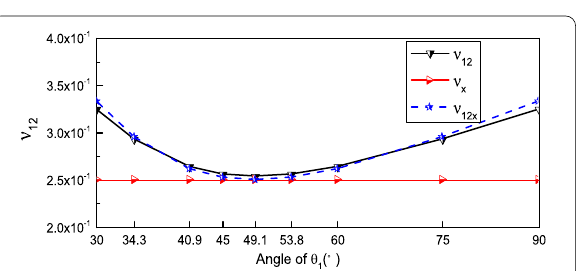
Figure 14 Elastic modulus E ′ 1 with varying θ 1 angle in the σ 1